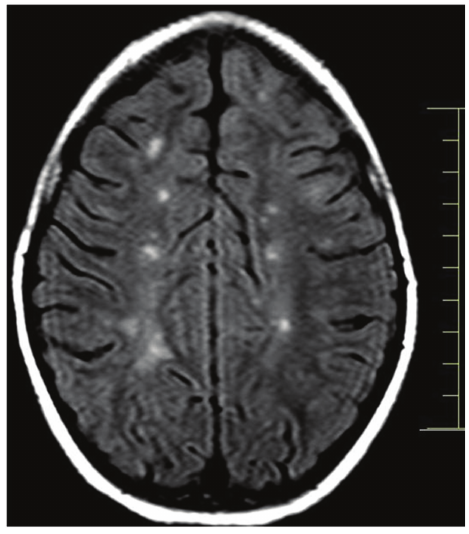
Figure 2: Brain MRI showing multiple juxtacortical lesions.